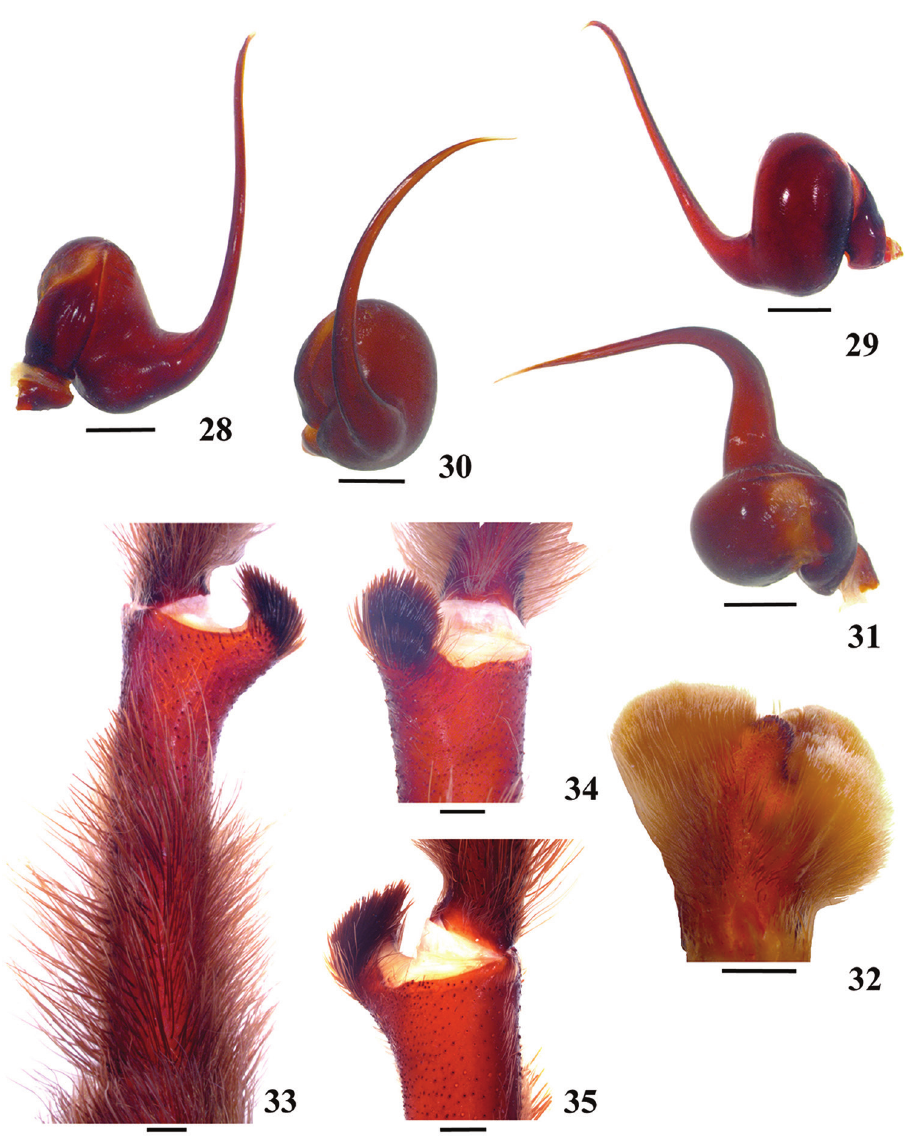
Figures 28–35. Avicularia avicularia (Linnaeus, 1758), male (MNRJ 13659A). 28–31 right palpal bulb (mirrored) 28 prolateral 29 retrolateral 30 frontal 31 dorsal 32 right cymbium, dorsal view (mirrored) 33–35 right tibial apophysis of leg I (mirrored) 33 prolateral 34 ventral 35 retrolateral. Scale bars = 1 mm. guard-setae with homogeneous dark coloration on anterior legs and guard-setae with darker base and contrasting whitish apex on posterior legs. Leg rings on distal femora, tibiae and metatarsi whitish. Abdomen dorsum with long reddish brown guard-setae with pink sheen and dark short body setae. Ventral abdomen